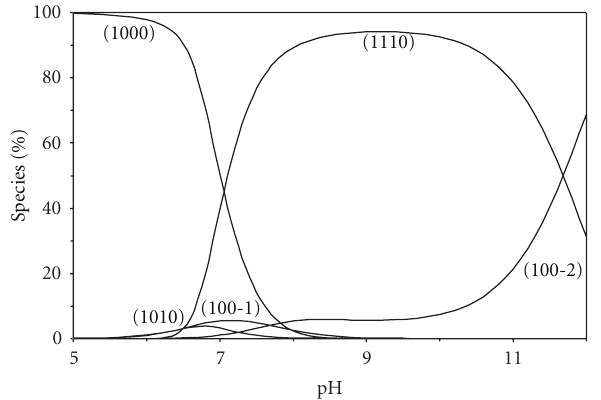
Figure 10: Concentration distribution of various species as a func- tion of pH in the [Zn(BAPP)(inosine)] system (1.25 mM of Zn 2+ , BAPP, and